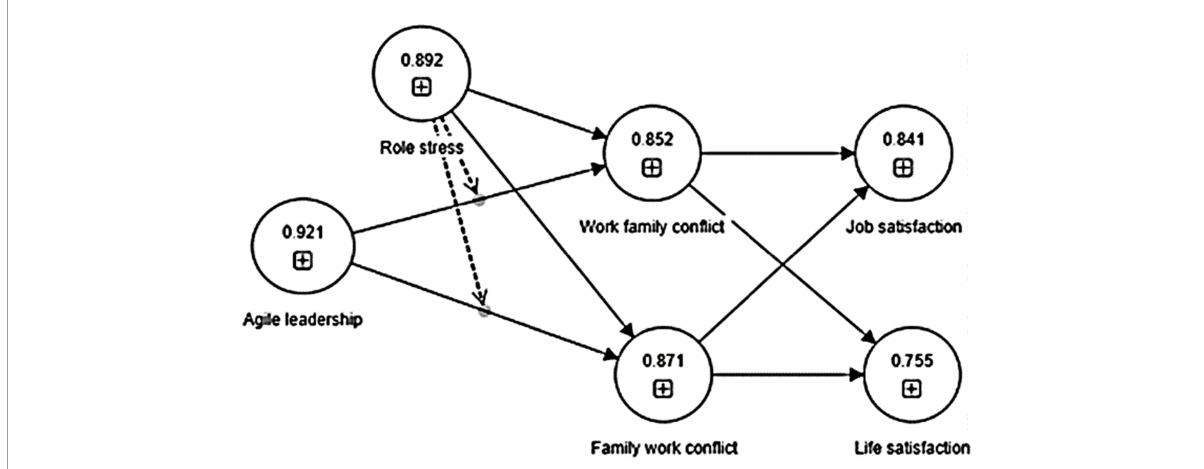
FIGURE3 Reliability model. ∗ The values within the variable show composite reliability of the constructs of the study.